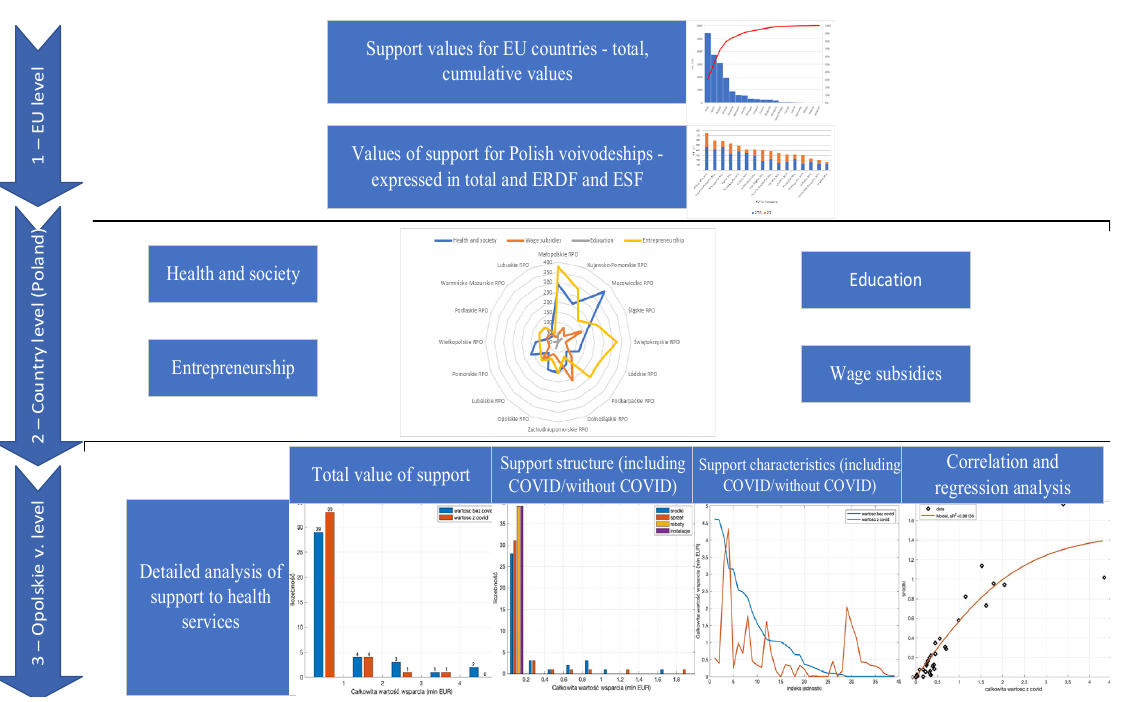
Figure 1. Stages of research implementation.